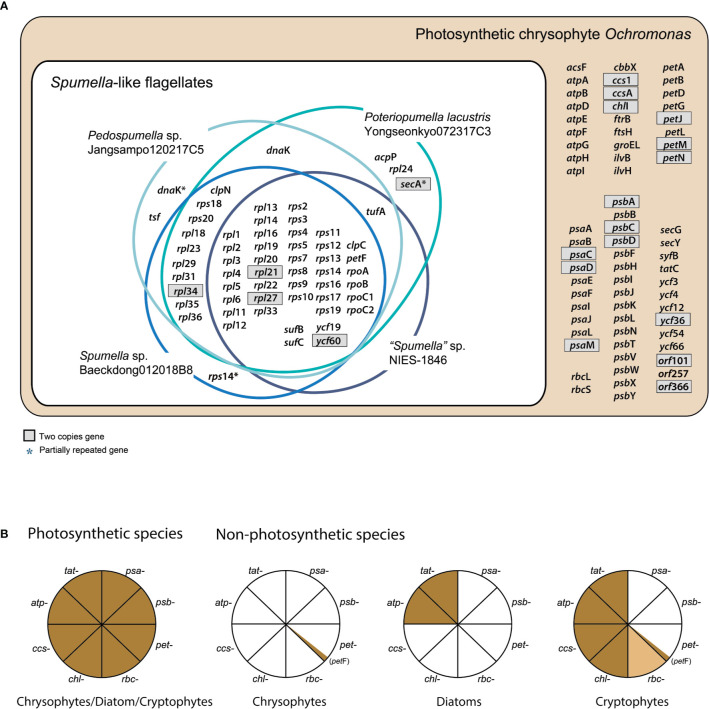

(A) Chrysophyte plastid genome content. Genes with two copies are shown in gray boxes. (B) Presence or absence of genes for photosystem I (PSI, psa-), photosystem II (PSII, psb-), the cytochrome b6/f complex (pet-), carbon fixation (rbc-), chlorophyll biosynthesis (chl-), cytochrome c biogenesis proteins (ccs-), the ATP synthase subunits (atp-), and the TAT system (tat-) are shown for three distantly related lineages, i.e., photosynthetic and non-photosynthetic chrysophytes, diatoms, and cryptophytes. Genes present/absent in plastid genomes are shown in brown or white, respectively. The rbc- gene present only in certain species is colored light brown. The data were derived from previously published studies (Donaher et al., 2009; Kamikawa et al., 2015; Kim et al., 2017; Dorrell et al., 2019; Kim et al., 2019; Tanifuji et al., 2020; this study).